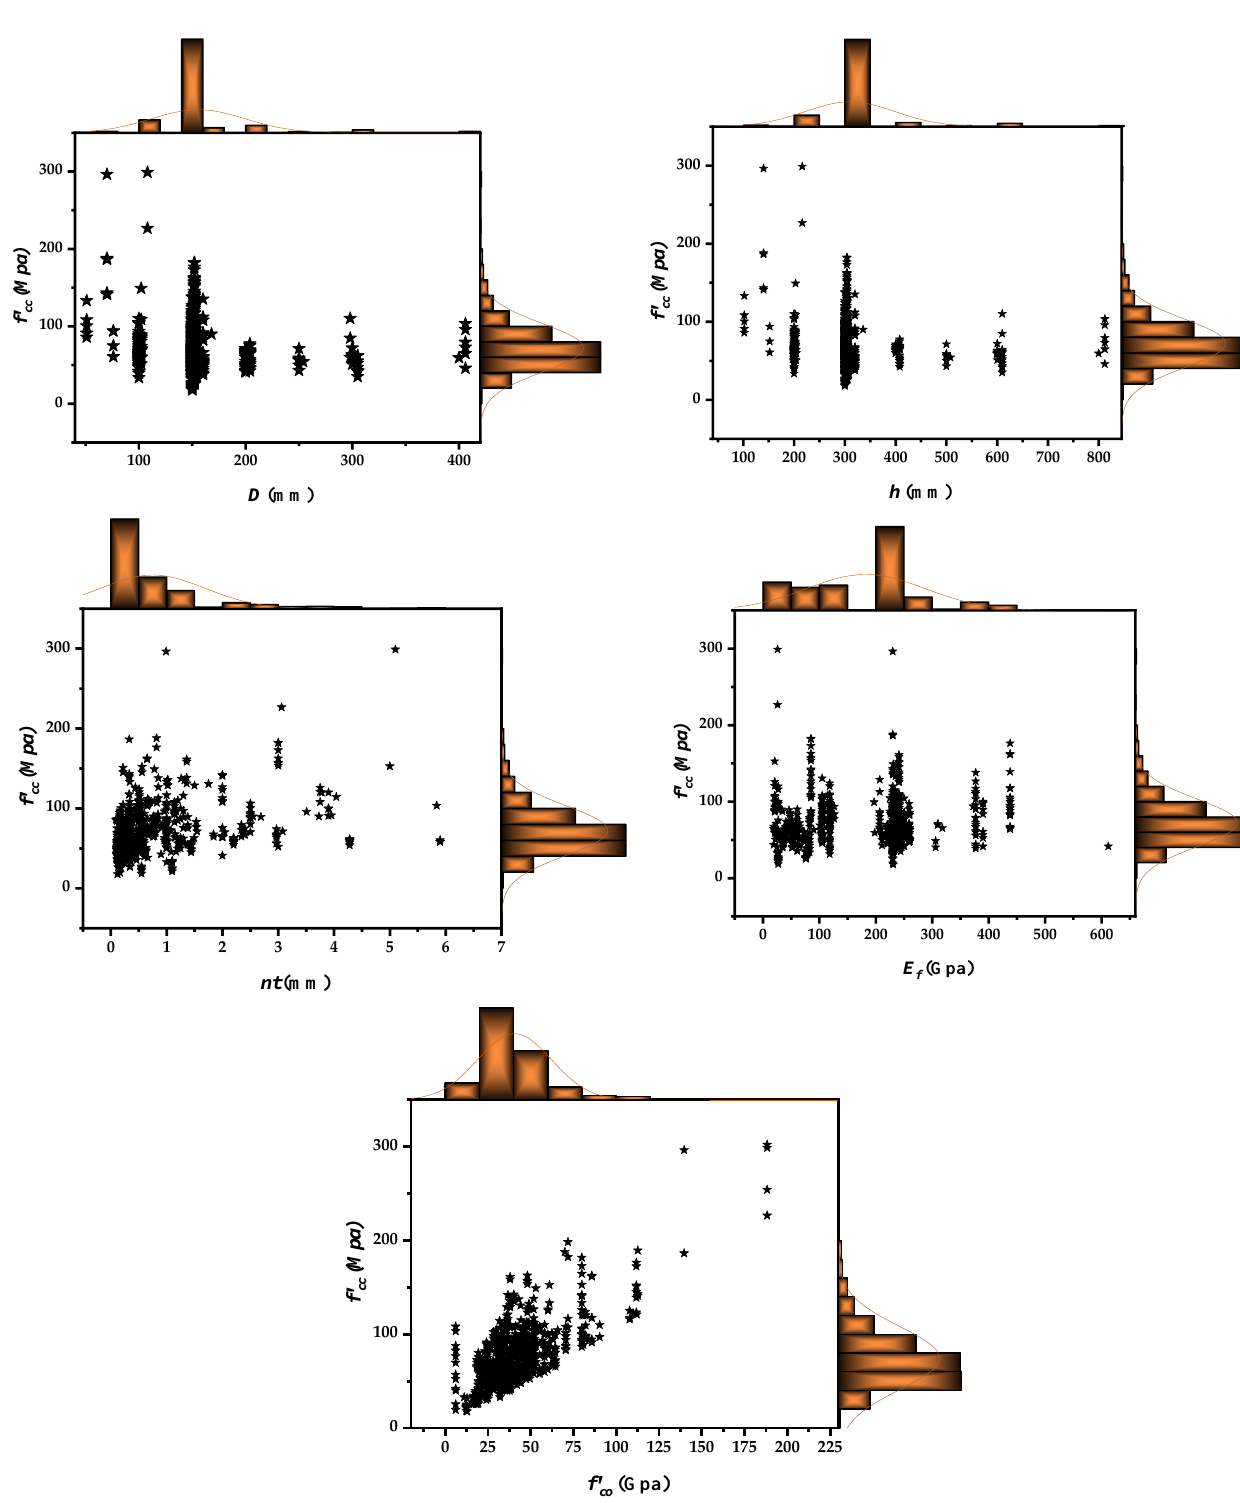
Figure 2. Marginal histograms for each predictor variable.